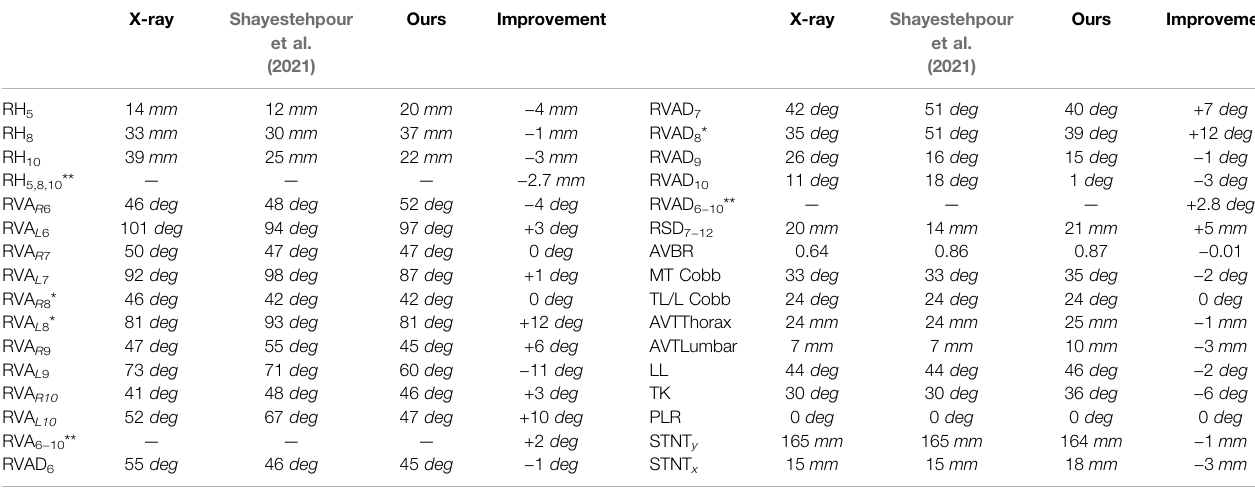
TABLE 4 | Comparison of fi tting results between our method and (Shayestehpour et al., 2021), on the normal-dose case (patient 1). The columns indicate, from left to right, clinical metrics measured on radiographs, metrics obtained using (Shayestehpour et al., 2021), metrics with our method, and error improvement thanks to our method (positive values indicate that our method outperforms (Shayestehpour et al., 2021)).